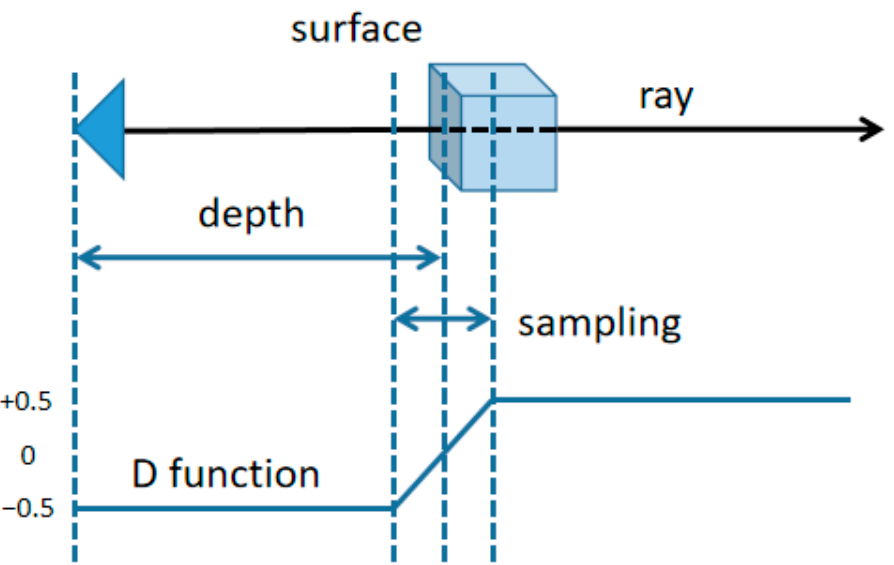
Figure 7. The sampling range of the rays and the variation curve of the constructed distance function are shown.